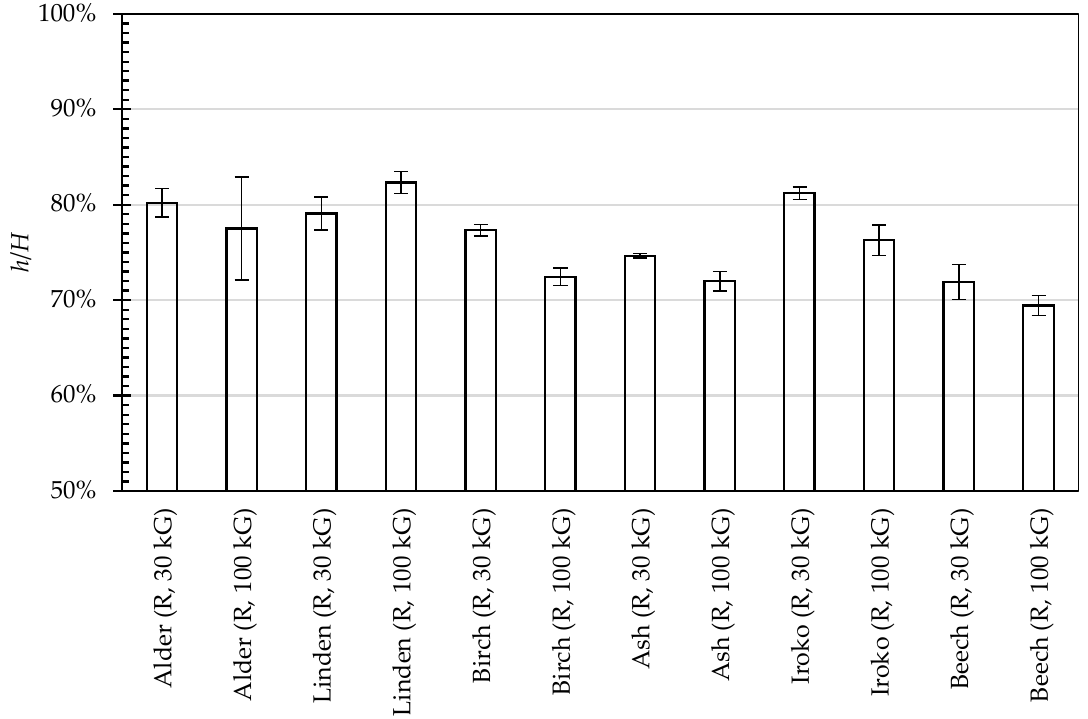
Figure 10. The R cross-section: the permanent imprint depth ( h ) shares the total imprint depth ( H ).